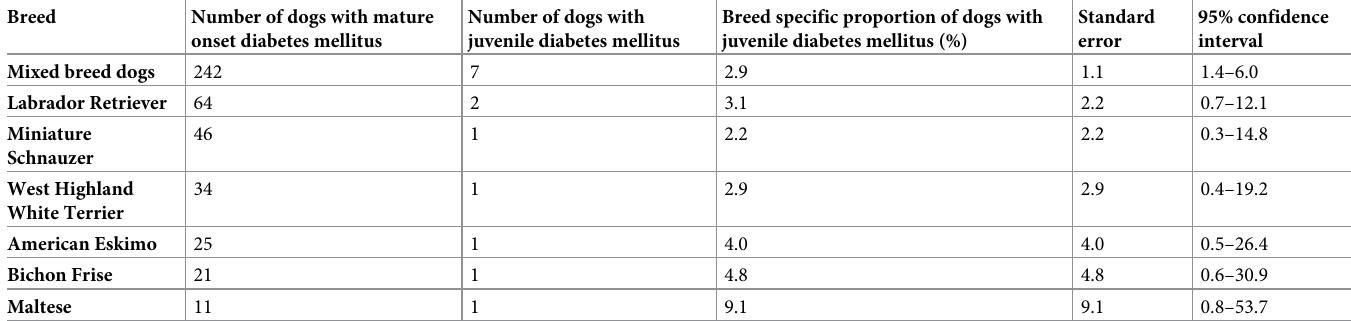
Table 1. The proportion of dogs with juvenile diabetes mellitus in breeds represented by > 10 dogs with mature onset diabetes mellitus. Breed Number of dogs with mature Number of dogs with Breed specific proportion of dogs with onset diabetes mellitus juvenile diabetes mellitus juvenile diabetes mellitus